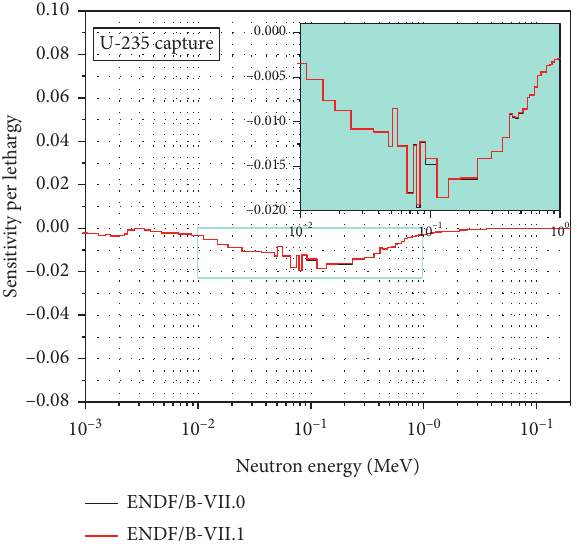
Figure 17: Energy-dependent sensitivities of k cross section.